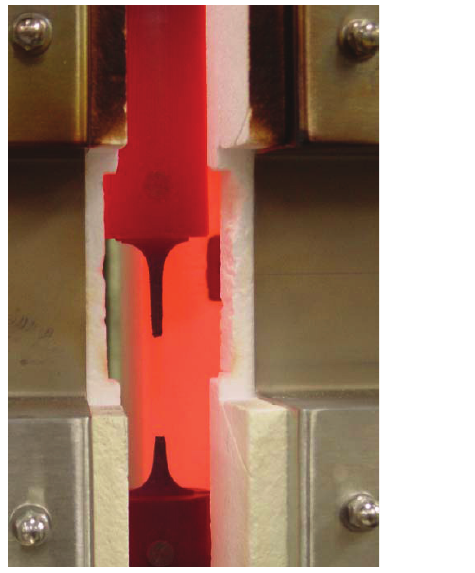
Figure 10. Experimental setup for tensile test with air cool- ing